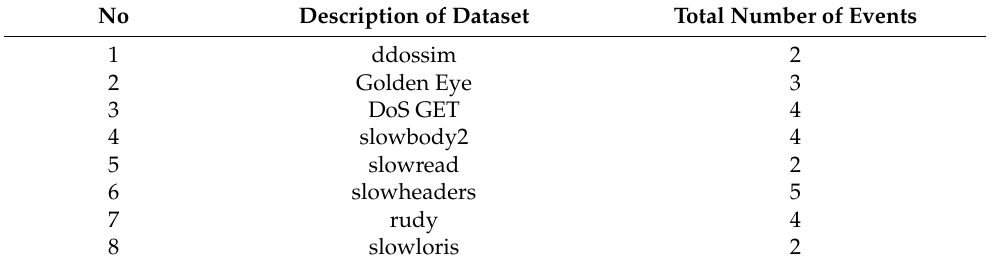
Table 2. CIC-DoS 2012 dataset.